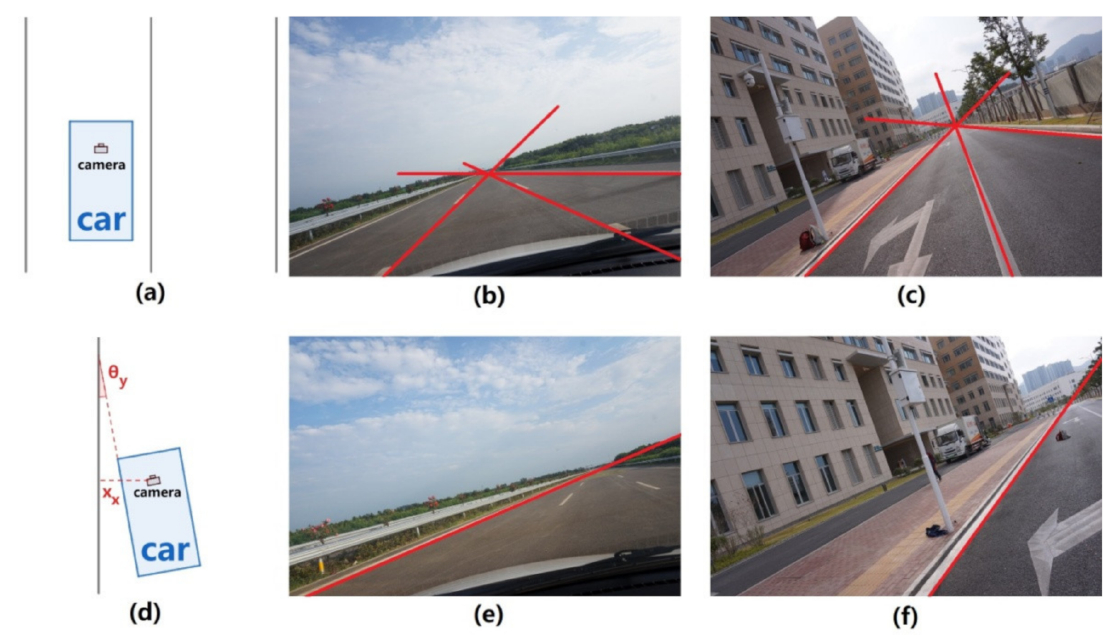
Figure 13. Example frames of the experiments and the corresponding top views of the environ- ments. ( a ) Top view of the camera calibration experiments. ( b ) Camera calibration of the highway